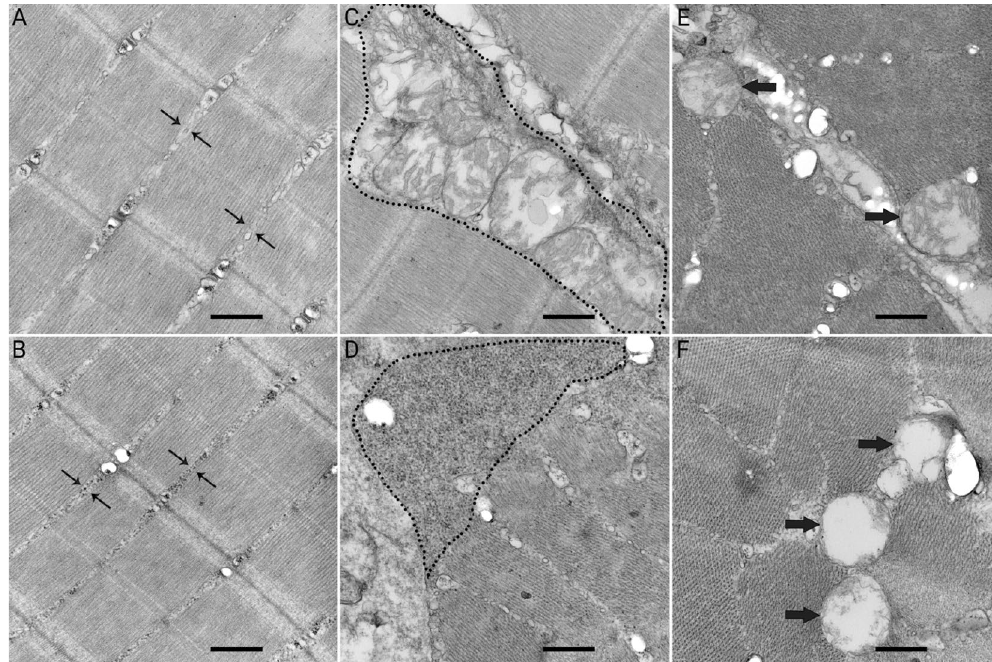
Figure 1. Ultra-thin section of skeletal muscle from the C0 group and the C24 group, bar = 500 nm. Little glycogen granules between the myofibrils in the C0 group ( A ). Some deposits of glycogen granules between the myofibrils in the C24 group ( B ). Mitochondria rather than glycogen granules are seen near the endomysium in the C0 group ( C ). Large accumulation of glycogen granules is seen near the endomysium of fish